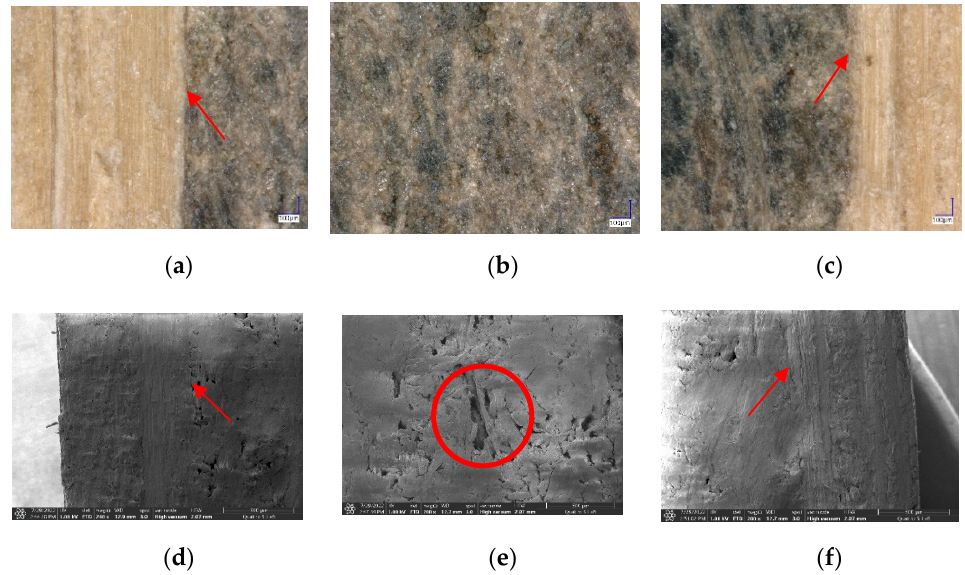
Figure 6. Morphology analysis of elephant dung particleboard layered with Belangke bamboo